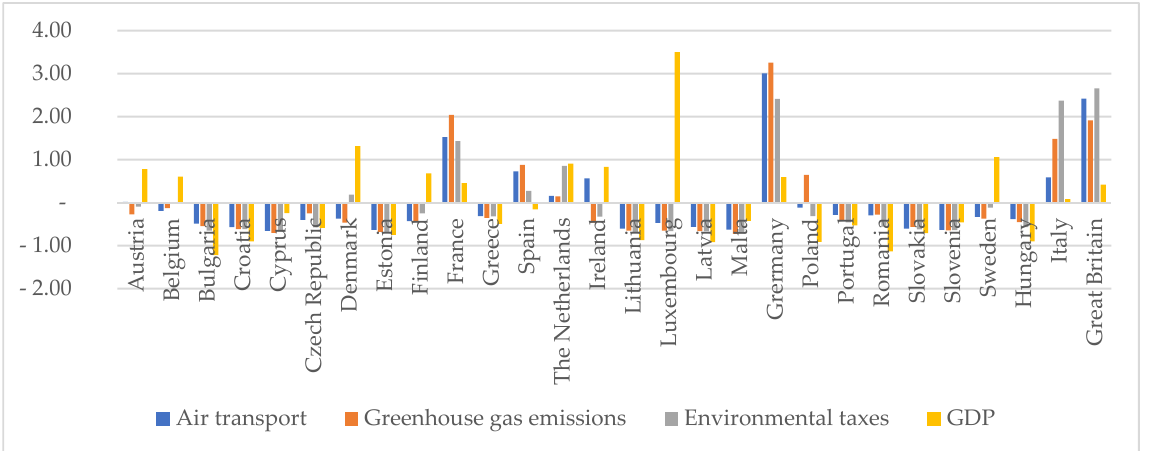
Figure A7. Distribution of European Union countries determined using Perkal index in 2013. Source: Reproduced from